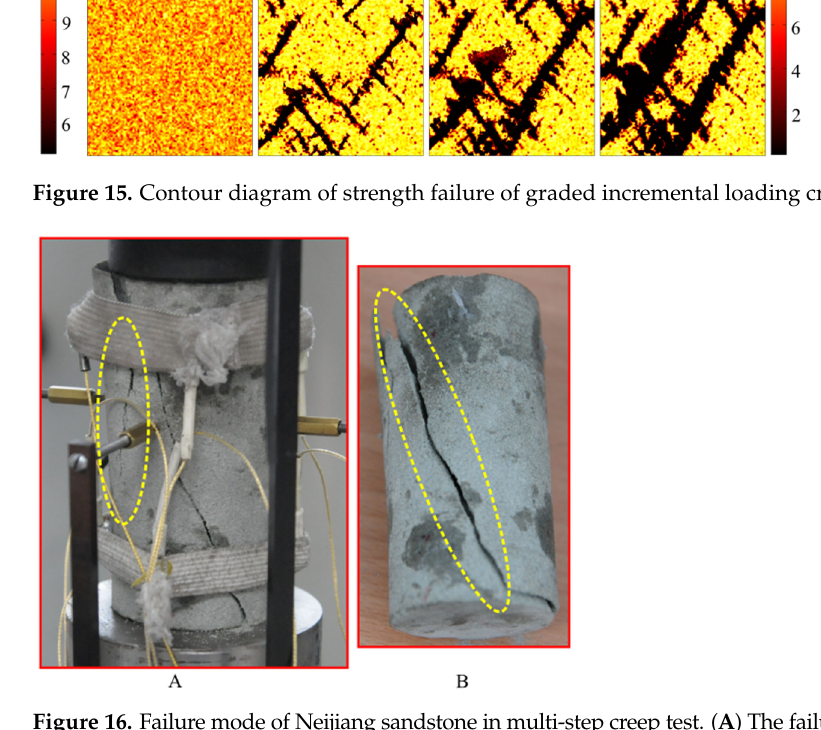
Figure 16. Failure mode of Neijiang sandstone in multi ‐ step creep test. ( A ) The failure mode focuses on the shear failure, and a small crack (highlighted by the yellow circle) occurs near the main fracture similar to that in the failure mode in the UCS tests. ( B ) A main shear fracture on another side opposite to Figure 16A.